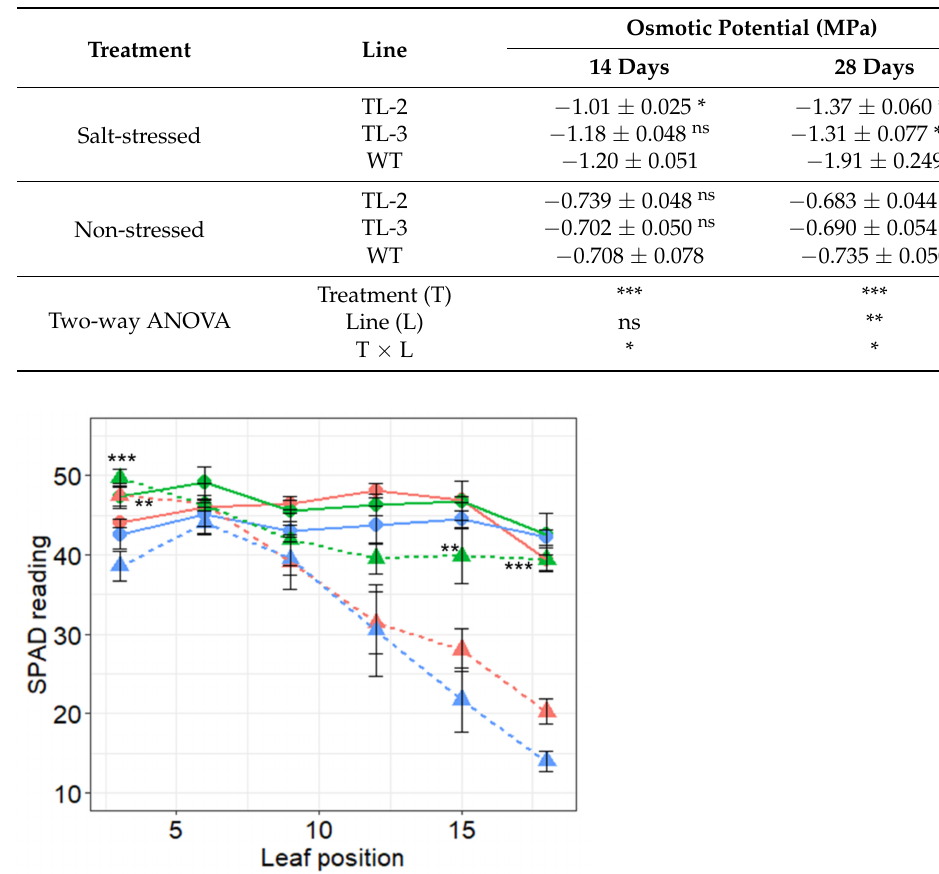
Table 3. Leaf osmotic potentials of transgenic faba bean lines TL-2, TL-3, and wild-type (WT) after 14 and 28 days of salt stress. Values are means ± SE. Asterisks indicate significant differences within treatment by Dunnett’s test using WT as control upon significant interaction indicated by two-way ANOVA. *** p < 0.001, ** p < 0.01, * p < 0.05, ns, insignificance with p > 0.05.